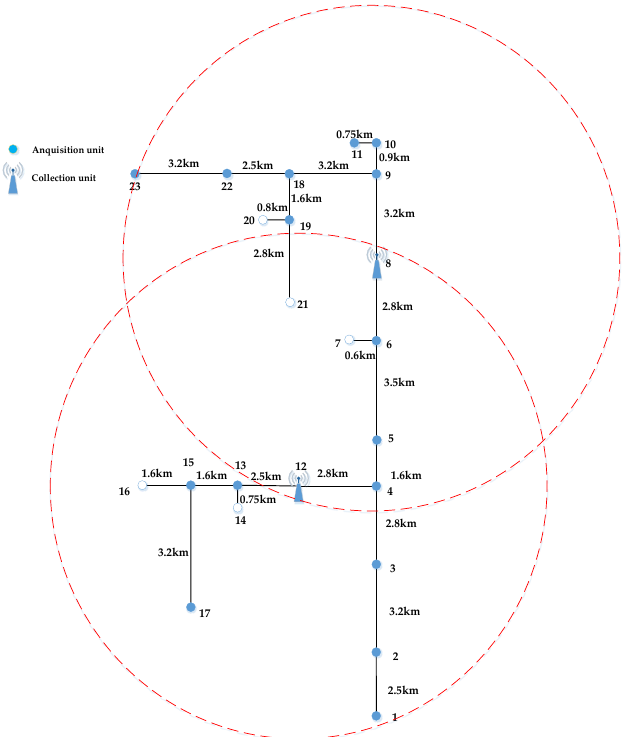
Figure 9. The installation position of IoT-based fault indicator when the speed is 2 km/h.